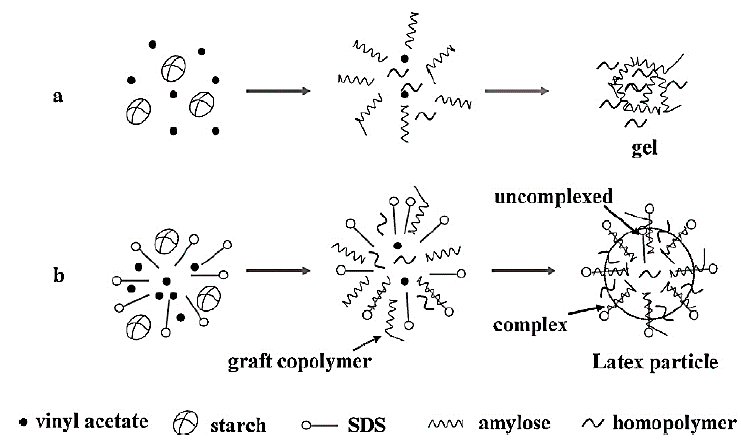
Figure 6. The schematic structure of starch-based wood adhesive ( a ) with sodium dodecyl sulfate (SDS); ( b ) without SDS [101], Reproduced with permission from Elsevier.